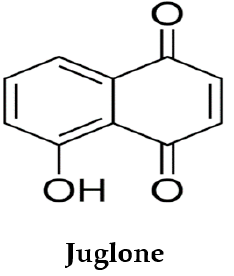
Figure 1. Chemical structure of juglone.